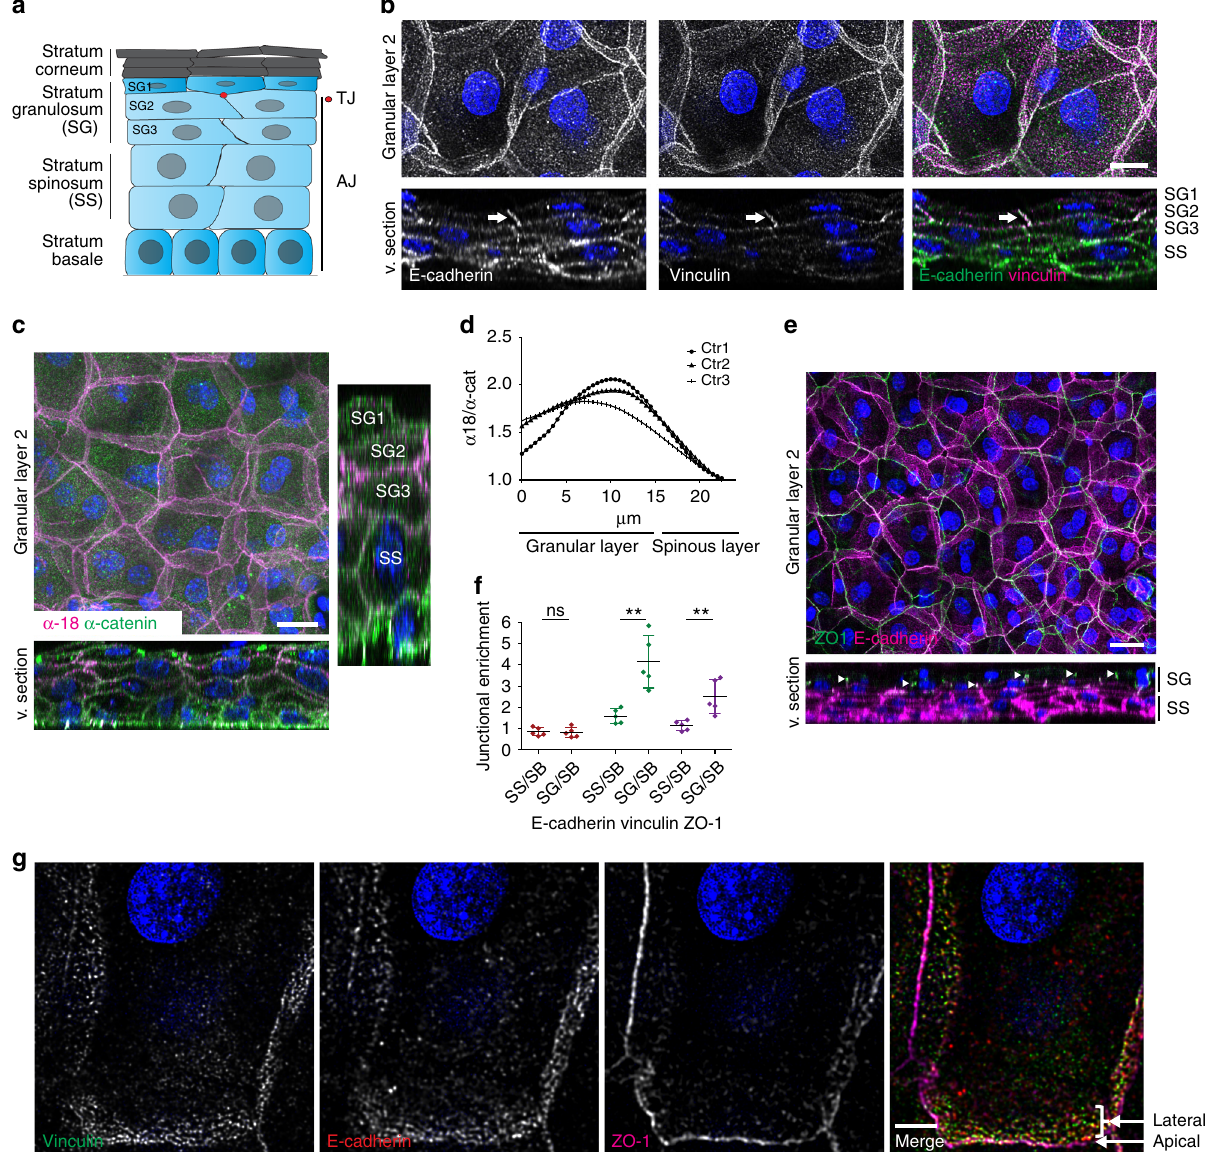
Fig. 1 Intercellular junctions are polarized across and within epidermal layers. a Cartoon depicting epidermal structure and distribution of junctions in different epidermal layers (TJ tight junctions; AJ adherens junctions). b Newborn epidermal whole-mount immuno fl uorescence analysis for tension-high (vinculin) adherens junctions (E-cadherin). Note that vinculin-positive junctions are primarily present in the granular layer 2 (SG2). Scale bar, 10 µ m. c Newborn epidermal whole-mount immuno fl uorescence analysis for total and tension-sensitive epitope ( α 18) of α -catenin showing that mechanosensitive α -catenin is only present in SG2. The right panel is a cross-sectional view stretched in Z direction to better visualize single layers. Scale bar, 20 µ m. d Quanti fi cation of fl uorescence intensity ratios in c of α 18 vs. total α -catenin in different layers. Curves show mean ratios from three stack pro fi les per biological replicate ( n = 3). e Staining for E-cadherin (AJ) and ZO-1 (TJ) (arrowheads) showing TJ enrichment in SG2. f Quanti fi cation of whole-mount junctional intensities of E-cadherin, ZO-1, and vinculin in different epidermal layers. Values were normalized to basal layer intensity. Mean values of 5 biological replicates are shown (dots, 10 junctions per replicate), P = 0.8105 (E-cadherin); 0.0064 (ZO-1); 0.0021 (Vinculin) with Student ’ s t -test, n = 5. Scale bar, 20 µ m. g SG2 projections from apical to subapical cell – cell junctions stained for vinculin, E-cadherin, and ZO-1 showing an basolateral AJs network and an apical TJ network. Scale bar, 5 µ m. b , c , e , g Deconvolved confocal stack projections and orthogonal views (virtual section; v.section) of newborn mouse epidermal whole mounts. b , c , e , g Representative image of n ≥ 3 biological replicates each. Nuclei were stained with DAPI